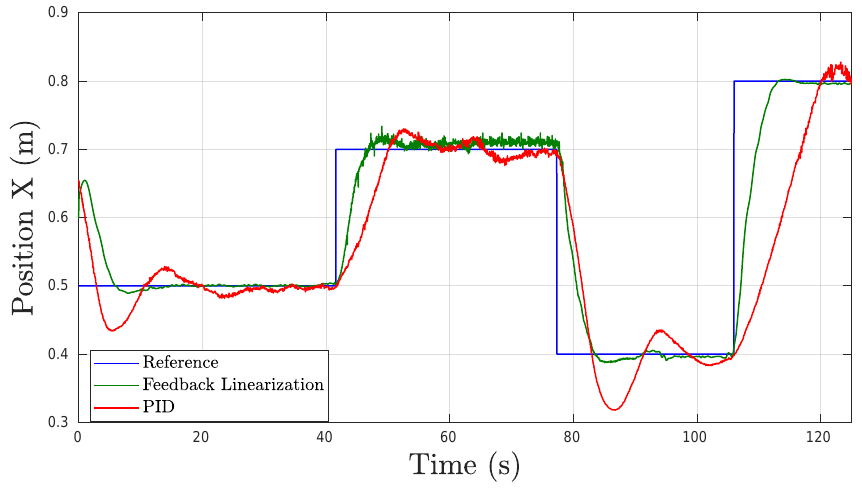
Figure 9. Experimental results obtained in underwater tests in Surge.